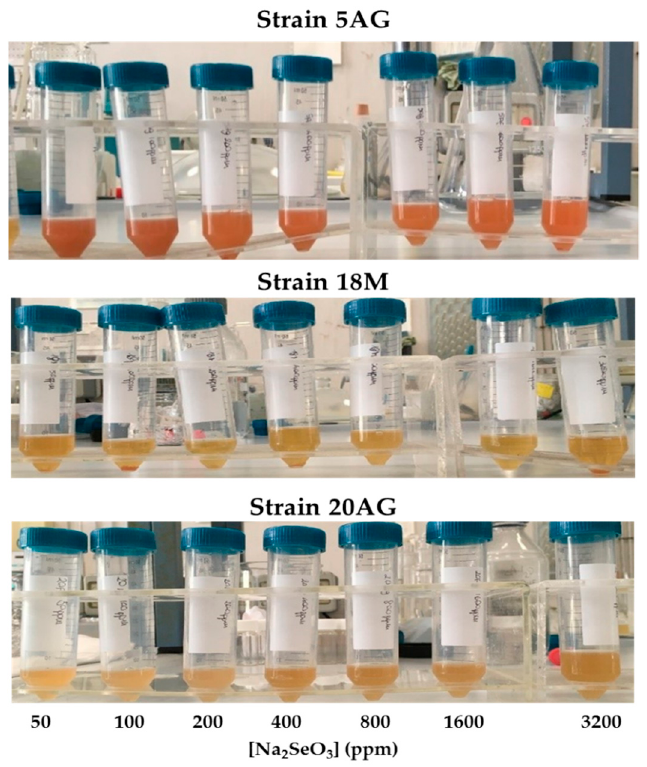
Figure 5. Selenite reduction by the haloalkaliphilic strains 5AG, 18M, and 20AG grown in medium A. The reduction of selenium (IV) to selenium (0) is evidenced by the appearance of the red color. In parallel, the cellular growth ability of all the strains in the presence of selenite was monitored by measuring the optical density of the incubation mixtures at 600 nm. The results are reported in Figure 6 where the optical density measured after 24 h incubation is reported as a function of the Na 2 SeO 3 concentration. Figure 6. Haloalkaliphilic strain growth in medium A in the presence of Na 2 SeO 3 . Experiments were carried out at 36 °C and 200 rpm for 24 h. The cellular growth was monitored by measuring the solutions’ optical density at 600 nm. As reported in Figure 6, the 5AG strain afforded a level of cellular growth higher than that of the other strains at all the selenite concentrations tested; therefore, this strain was selected for the biosynthesis of SeNPs. Since the highest cellular growth of 5AG was obtained in the presence of 200 ppm Na 2 SeO 3 , the production of nanoparticles was carried